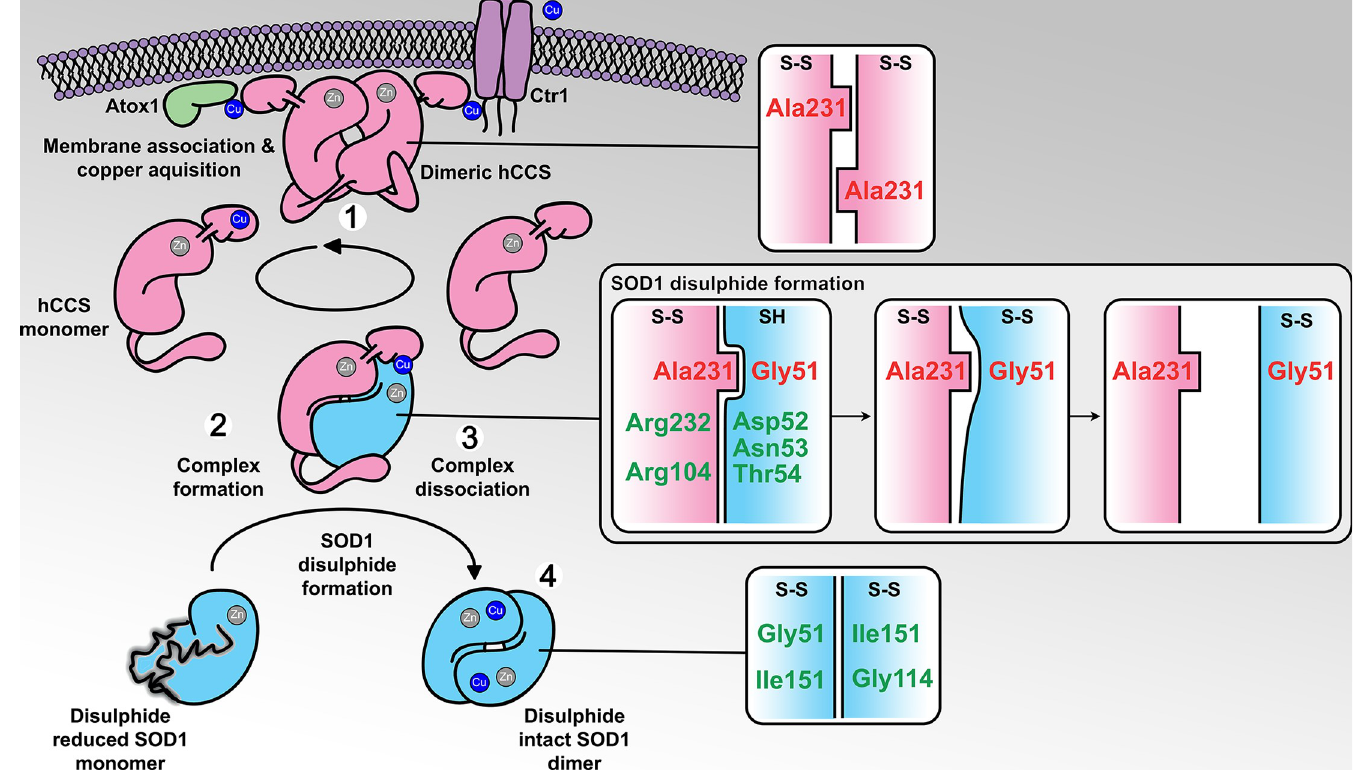
Fig 6. hCCS-catalysed hSOD1 activation. 1 . hCCS Ala231 facilitates a dynamic association with membranes while mobilising monomeric hCCS for complexation with hSOD1. 2 . Noncovalent interactions between hCCS domain II and the GDNT motif of the plastic hSOD1 disulphide sub-loop dictate molecular recognition. Complexation-induced conformational rearrangement prepares hSOD1 to receive copper, while impeding disulphide formation. 3 . hSOD1 disulphide formation breaks GDNT motif interactions, rotates the SOD1 disulphide loop, and weakens heterodimer affinity. 4 . hSOD1 forms a stable, active homodimer. hCCS can homodimerise and relocate back to the cytoplasmic membrane. hCCS, pink; hSOD1, blue. Panels show interactions across dimer interfaces, with disulphide status indicated as SH, reduced; S-S, intact. Ctr1, copper transporter-1; GDNT, Gly51-Asp52-Asn53-Thr54; hCCS, human copper chaperone for SOD1; hSOD1, human superoxide dismutase-